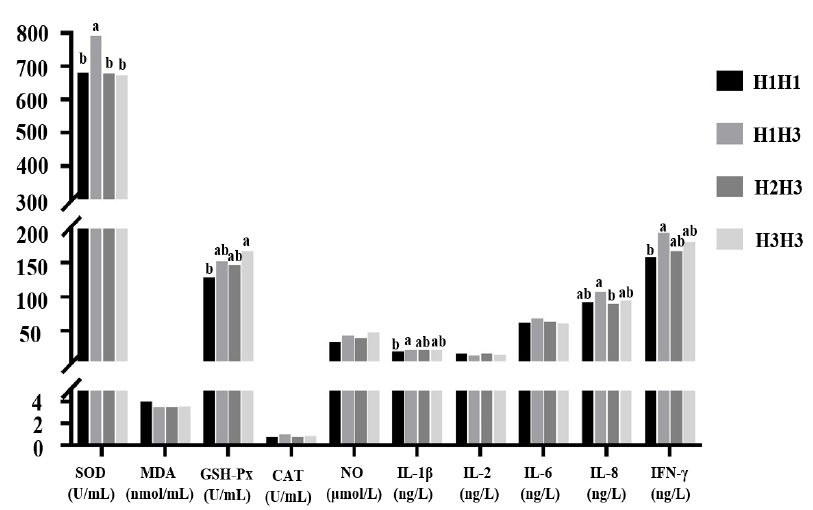
Figure 7. E ff ect of di ff erent haplotype combinations of the IL-8 gene on resistance Figure 7. Effect of different haplotype combinations of the IL-8 gene on resistance indexes. .